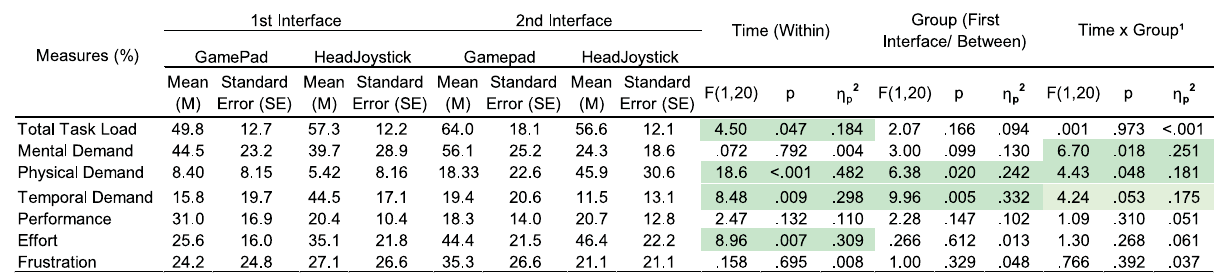
Figure 7C . ANOVA revealed a main effect of time, (cid:2) . 279, indicating an overall F ( 1 . 99 , 39 . 8 ) (cid:2) 7 . 72 , p < . 001 , η 2 p